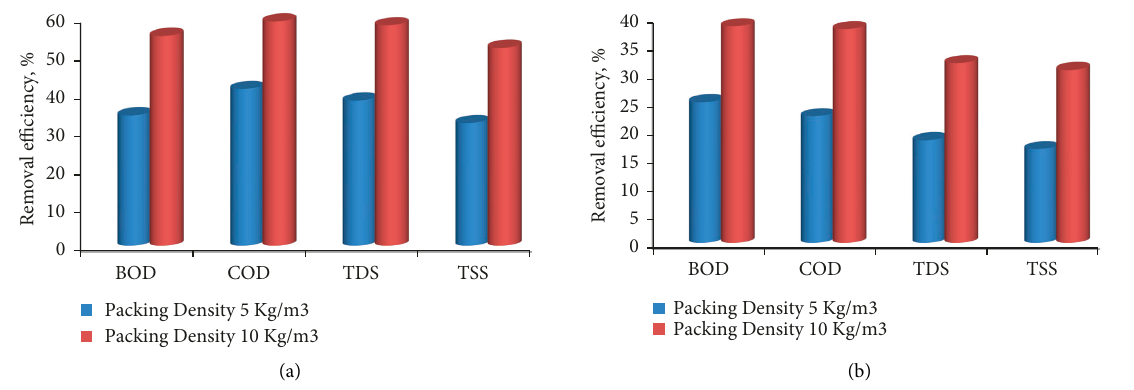
Figure 7: Effect of (a) Coir filter media depth (b) Areca filter media depth for the treatment of wastewater.